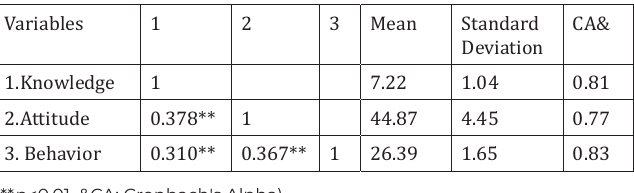
Correlation, reliability and statistical findings